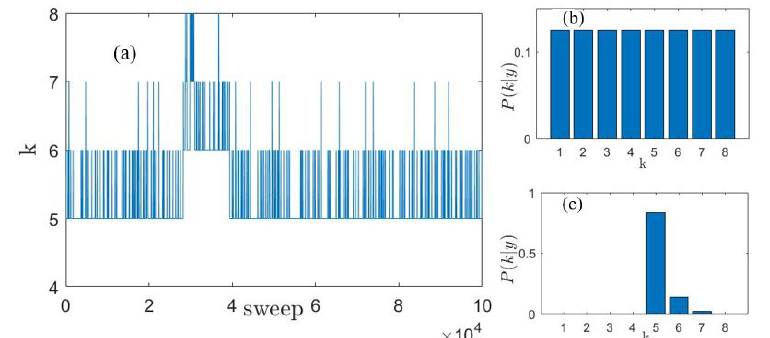
Figure 2. Traceplot (panel a ) showing the model selected at each MCMC sweep, prior (panel b ) and posterior (panel c ) distribution for the number k of inelastic components in the spectrum of the AuNP suspension at Q = 21 nm − 1 .